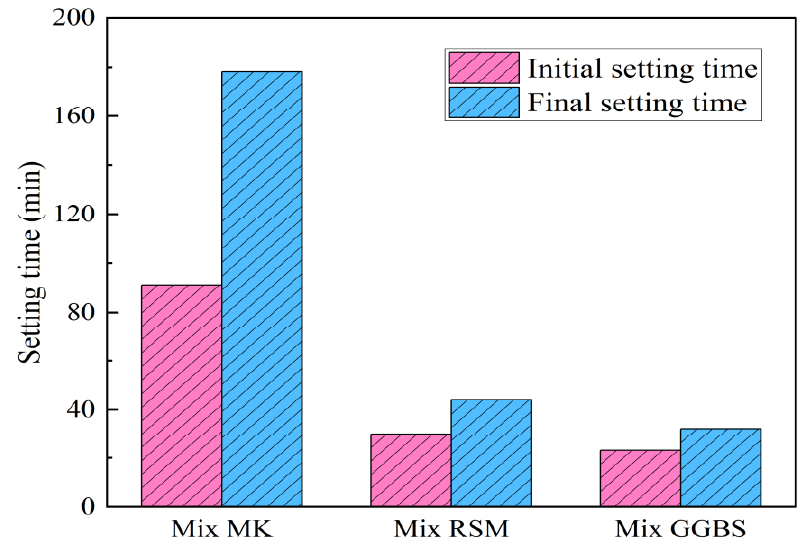
Figure 17. Setting time of geopolymer.